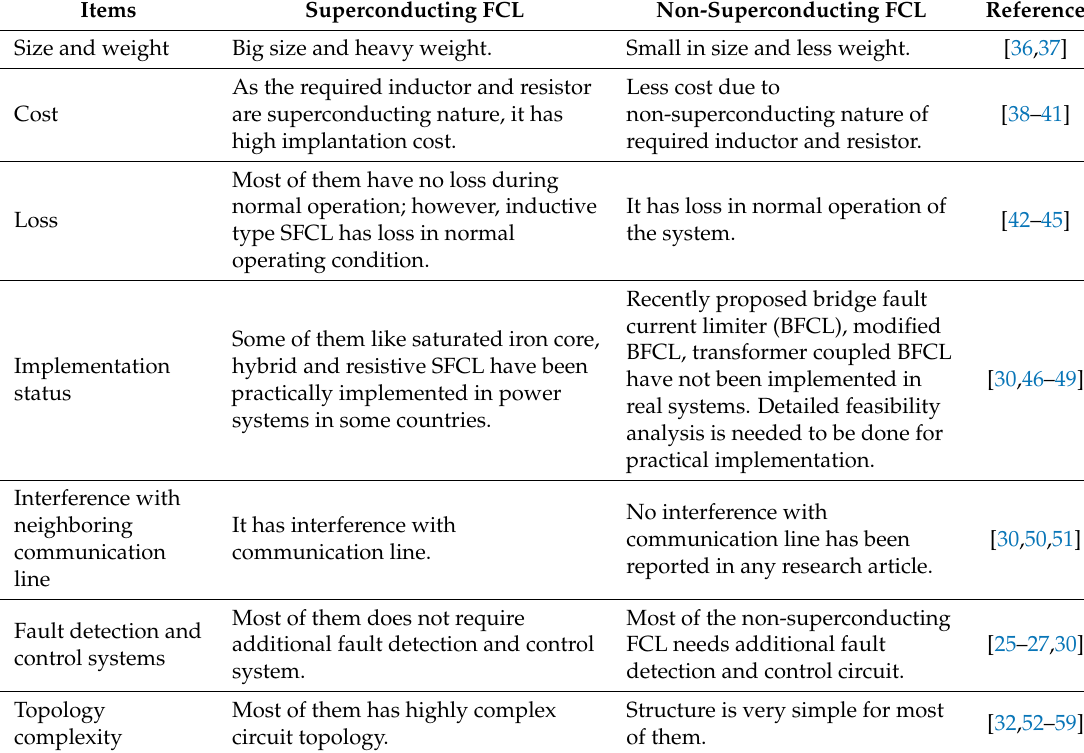
Table 1. Comparisons of superconducting and non-superconducting FCLs.